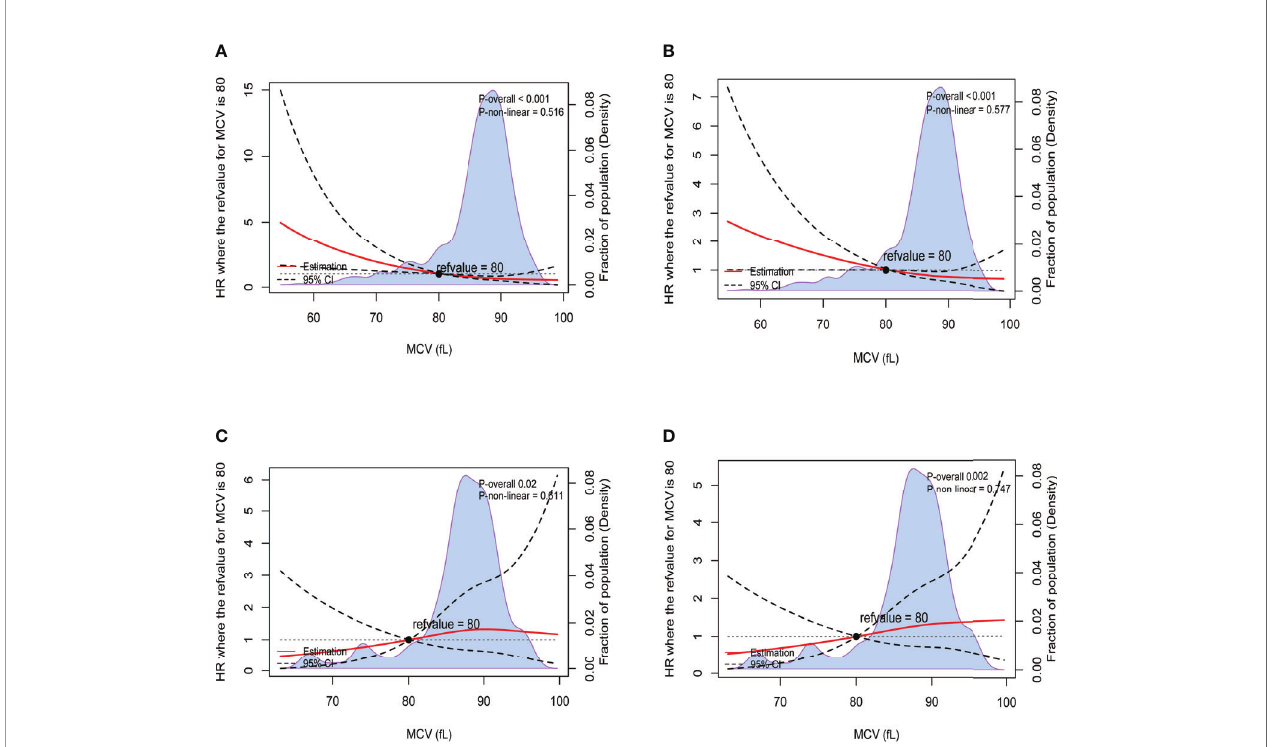
FIGURE 3 | Preoperative MCV and the corresponding hazard ratios on a continuous scale with the implications of habitual alcohol intake, including (A) . OS after adjusting for other prognostic factors, without habitual alcohol intake; (B) . RFS after adjusting for other prognostic factors, without habitual alcohol intake; (C) . OS after adjusting for other prognostic factors, with habitual alcohol intake; (D) . RFS after adjusting for other prognostic factors, with habitual alcohol intake. Analyses were conducted using restricted cubic splines, with hazard ratios and 95% con fi dence intervals from multivariate Cox proportional hazards regression. The pretreatment MCV of 80fL was selected as the reference. The purple area indicated the distribution of concentration of the pretreatment